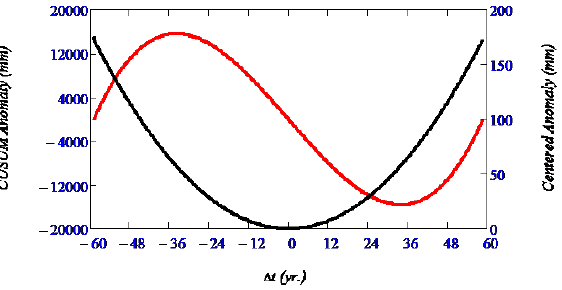
Fig. 1. The graph is intended to show the discernable properties of the CUSUM of a uniform acceleration and its magnification (refer- enced to the two different vertical axes for clarity). Parabolic be- haviour of a centered sea level anomaly due to a uniform acceler- ation a = 0.10 mm/yr. is shown in black and referenced to the right vertical axis. Its CUSUM, shown in red , is referenced to the left vertical